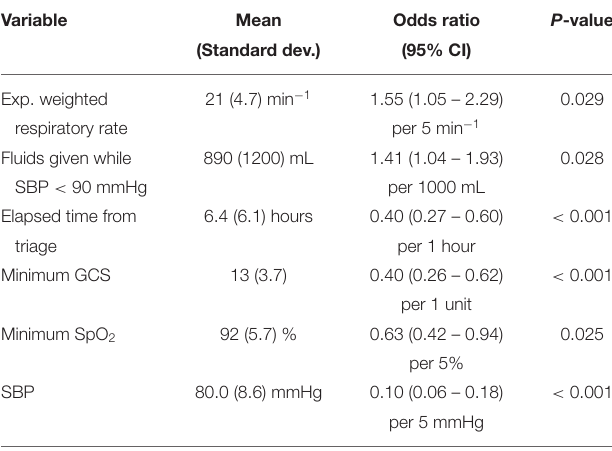
TABLE 1 | Final logistic regression model, with means and standard deviations from the training set for the selected variables (used for standardization in model development) provided as a